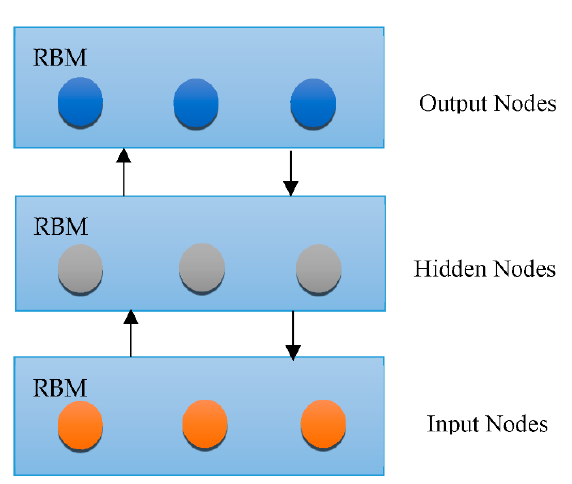
Figure 7. DBN architecture .